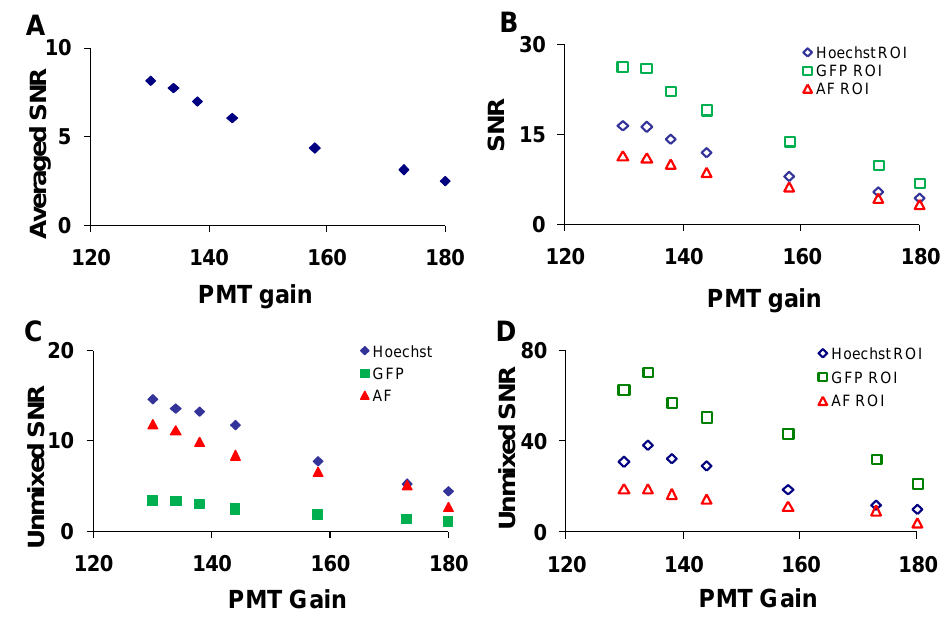
Figure 7. Increased photomultiplier tube (PMT) gain (at constant signal level, achieved by decreasing the laser intensity) resulted in decreased signal-to-noise ratio (SNR) for hyperspectral confocal images. ( A ) The wavelength-averaged SNR for an entire field of view; ( B ) the wavelength-averaged SNR for selected regions of interest (ROI) that contained high fluorescence emission from one of the spectral components (Hoechst, green fluorescent protein (GFP), autofluorescence (AF)); ( C ) the SNR averaged over an entire field of view for linearly unmixed images; ( D ) the SNR for the same ROI as B, but for linearly unmixed